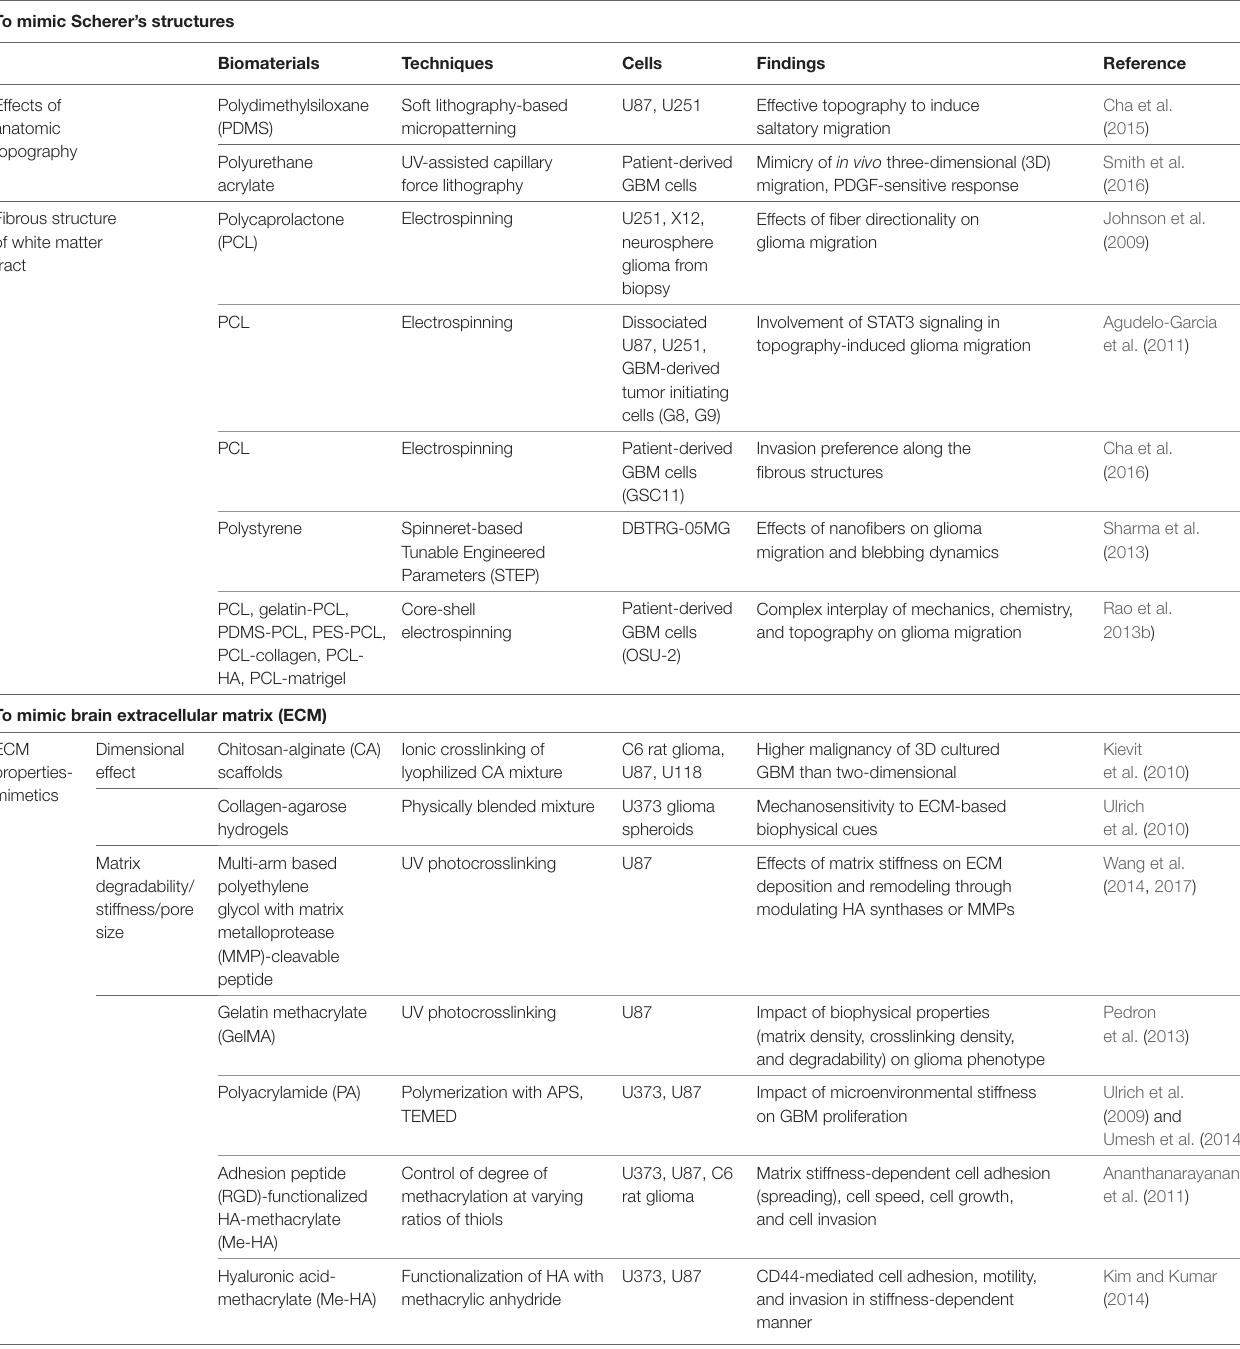
TABLe 1 | Representative approaches used to mimic glioblastoma multiforme (GBM) microenvironment. To mimic Scherer’s